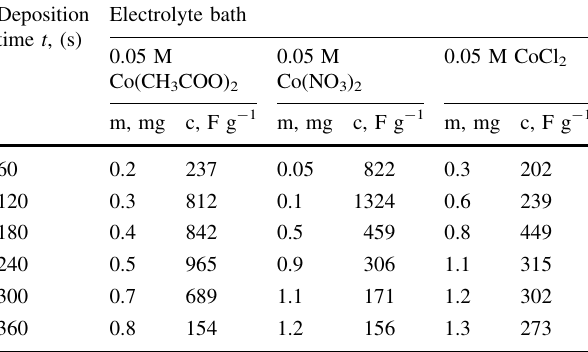
Table 2 Capacitive characteristics of Co(OH) 2 films on metal fiber filter Bekipor ST 20AL3 Deposition time t ,